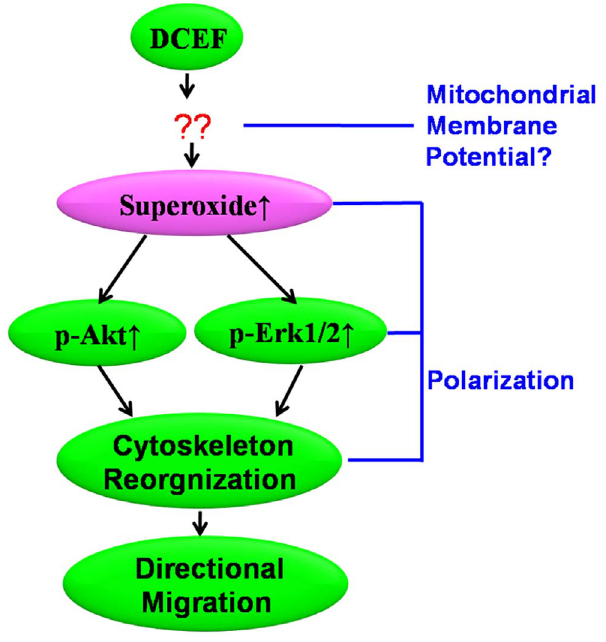
Figure 7. Schematic diagram of superoxide acting as a ‘‘bridge’’ between the extracellular electric stimulation and the intracellular signals in electrotaxis. DCEF induces the generation of superoxide. The superoxide then activates the Erk1/2 and Akt. The activation of these signaling pathways might be critical for the rearrangement and polarization of the cytoskeleton, which gears up the directional migration.